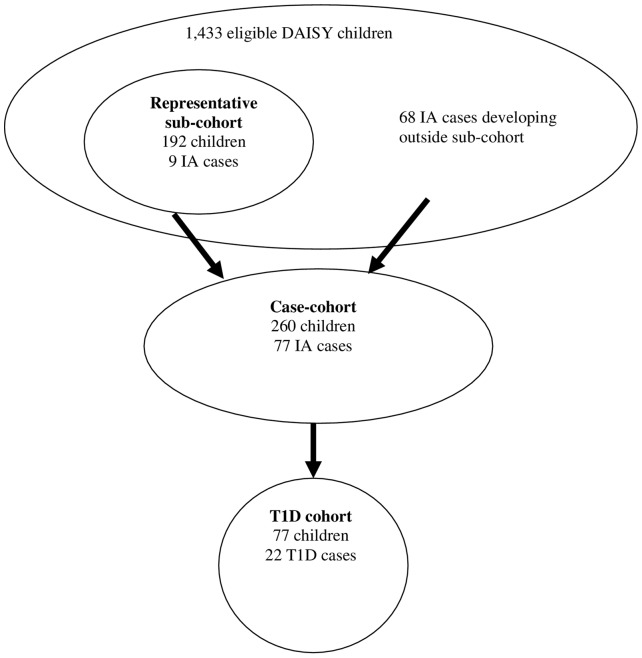
Selection of the analysis cohorts.